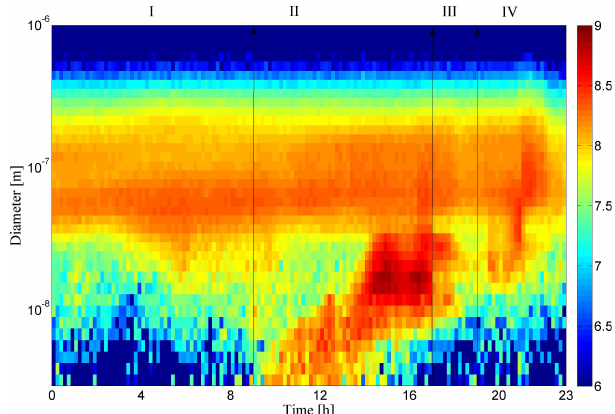
Fig. 2b. As in (a), but for inversion of the instrument kernel matrix ( x INV ) .